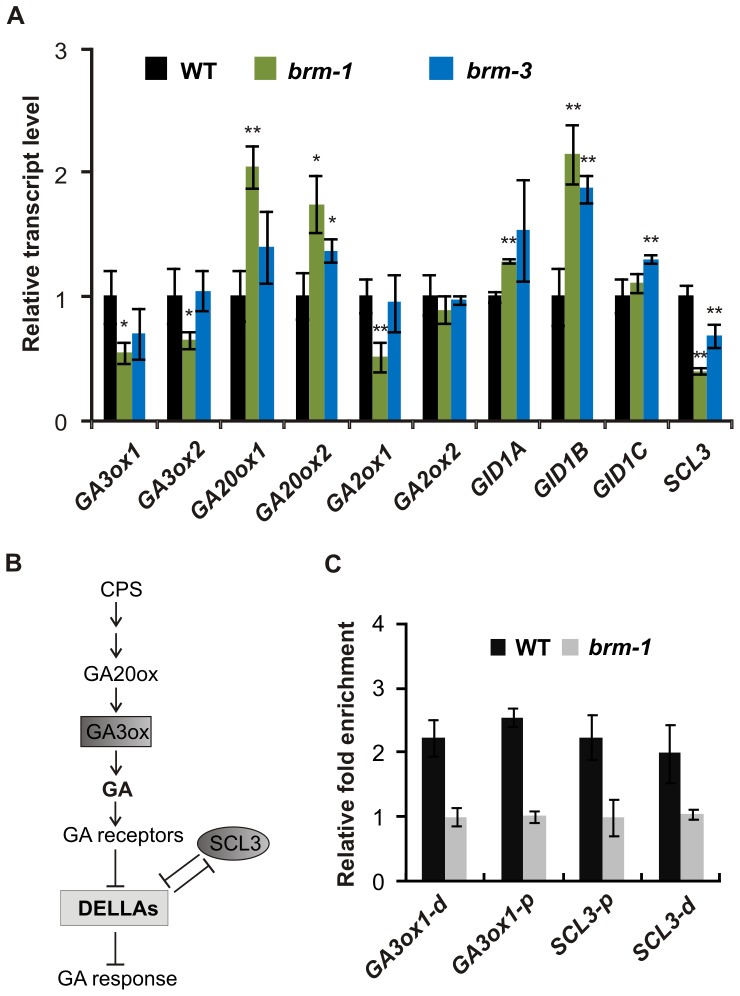
BRM directly regulates the expression of the GA3ox1 and SCL3 genes.(A), RT-qPCR analysis of relative transcript levels of GA biosynthesis and signaling genes in 18-d-old wild type, brm-1 and brm-3 lines. The housekeeping genes PP2A and GAPC were used as normalization controls. RT-qPCR data are the means ± s.d. of 3 biological replicates. Transcript levels in the wild type were set to 1. Asterisks indicate significant differences from the wild type plants with p<0.05 (*) or p<0.01 (**). (B), Simplified model of the GA signaling pathway. (C), BRM recruitment to the promoters of GA3ox1 and SCL3 in wild type and brm-1 plants, analyzed by ChIP-qPCR. The signal obtained for the PP2A promoter region was used to normalize the qPCR results in each sample. Distal (d) and proximal (p) promoter sequences relative to the start codon of each gene were analyzed. Fold enrichment of each region in the wild type was calculated relative to the brm-1 sample. The value of ChIP enrichment in brm-1 was set to 1. Data are the means ± s.e. from 3 reactions in one ChIP experiment. Similar results were obtained in separate experiments.